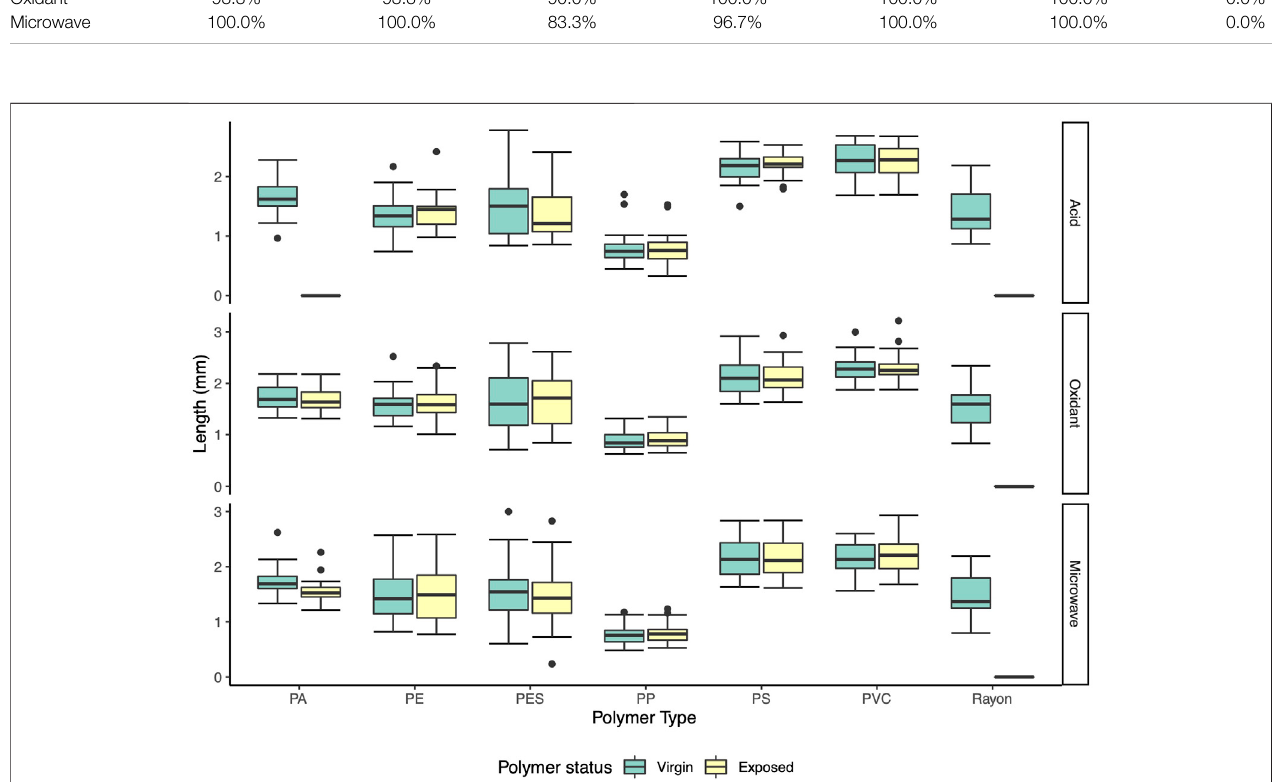
FIGURE 6 | Size distribution of virgin and exposed polymers. PA — polyamide, PE — polyethylene, PES — polyester, PP — polypropylene, PS — polystyrene, PVC — polyvinyl chloride.